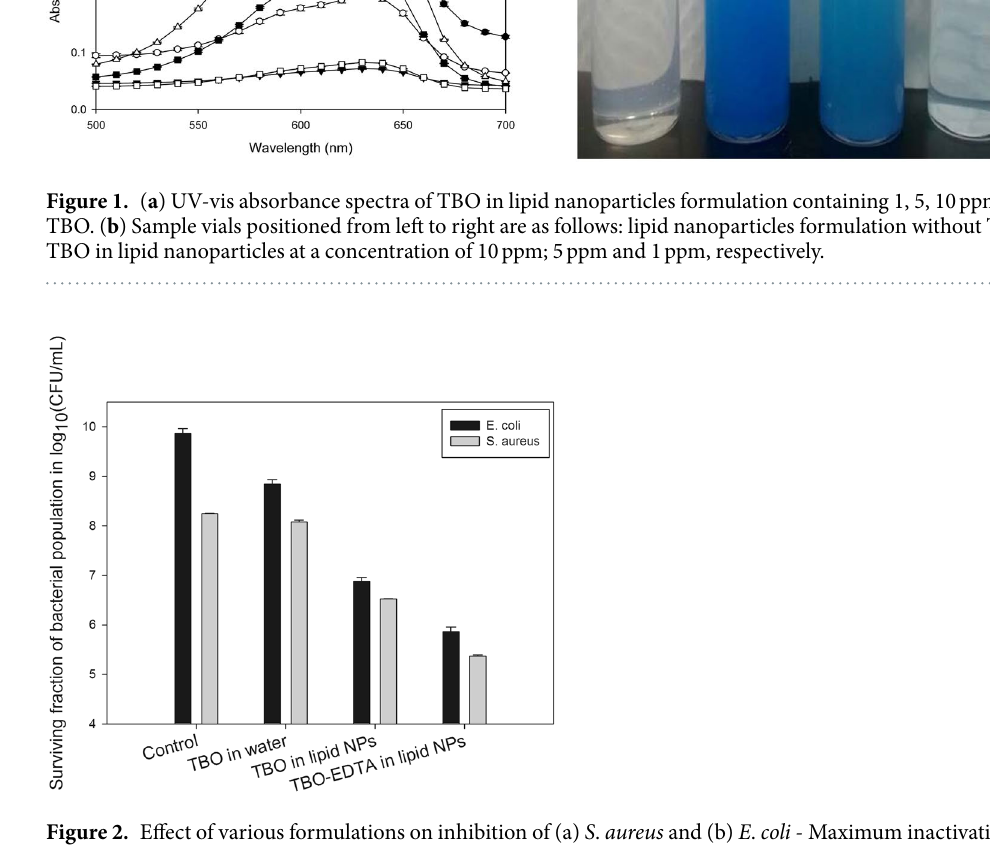
Figure 2. Effect of various formulations on inhibition of (a) S . aureus and (b) E . coli - Maximum inactivation was achieved with combination of TBO in lipid nanoparticles with EDTA. The inactivation of TBO in water was much lesser than TBO in lipid nanoparticles. Significant differences between the control groups and the treated groups have been denoted at a probability value < 0.05 ( *